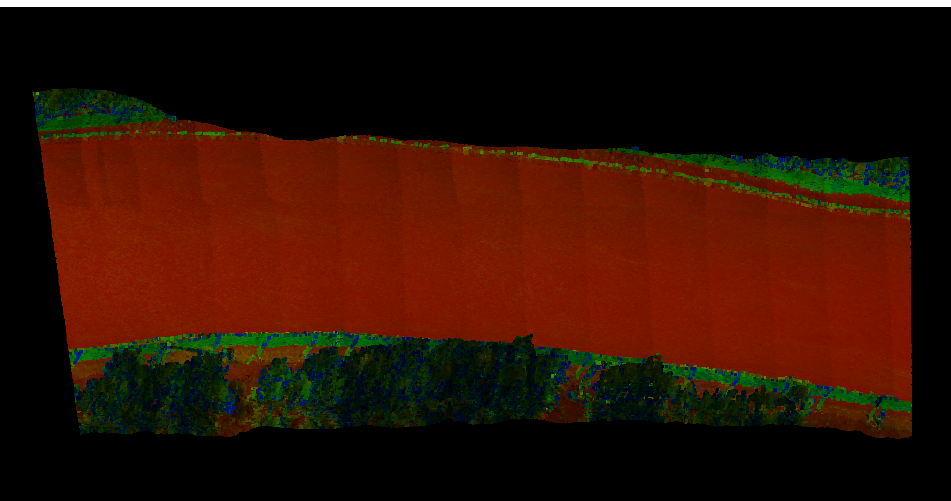
Figure 14. Adding colors to the datasets of Figure